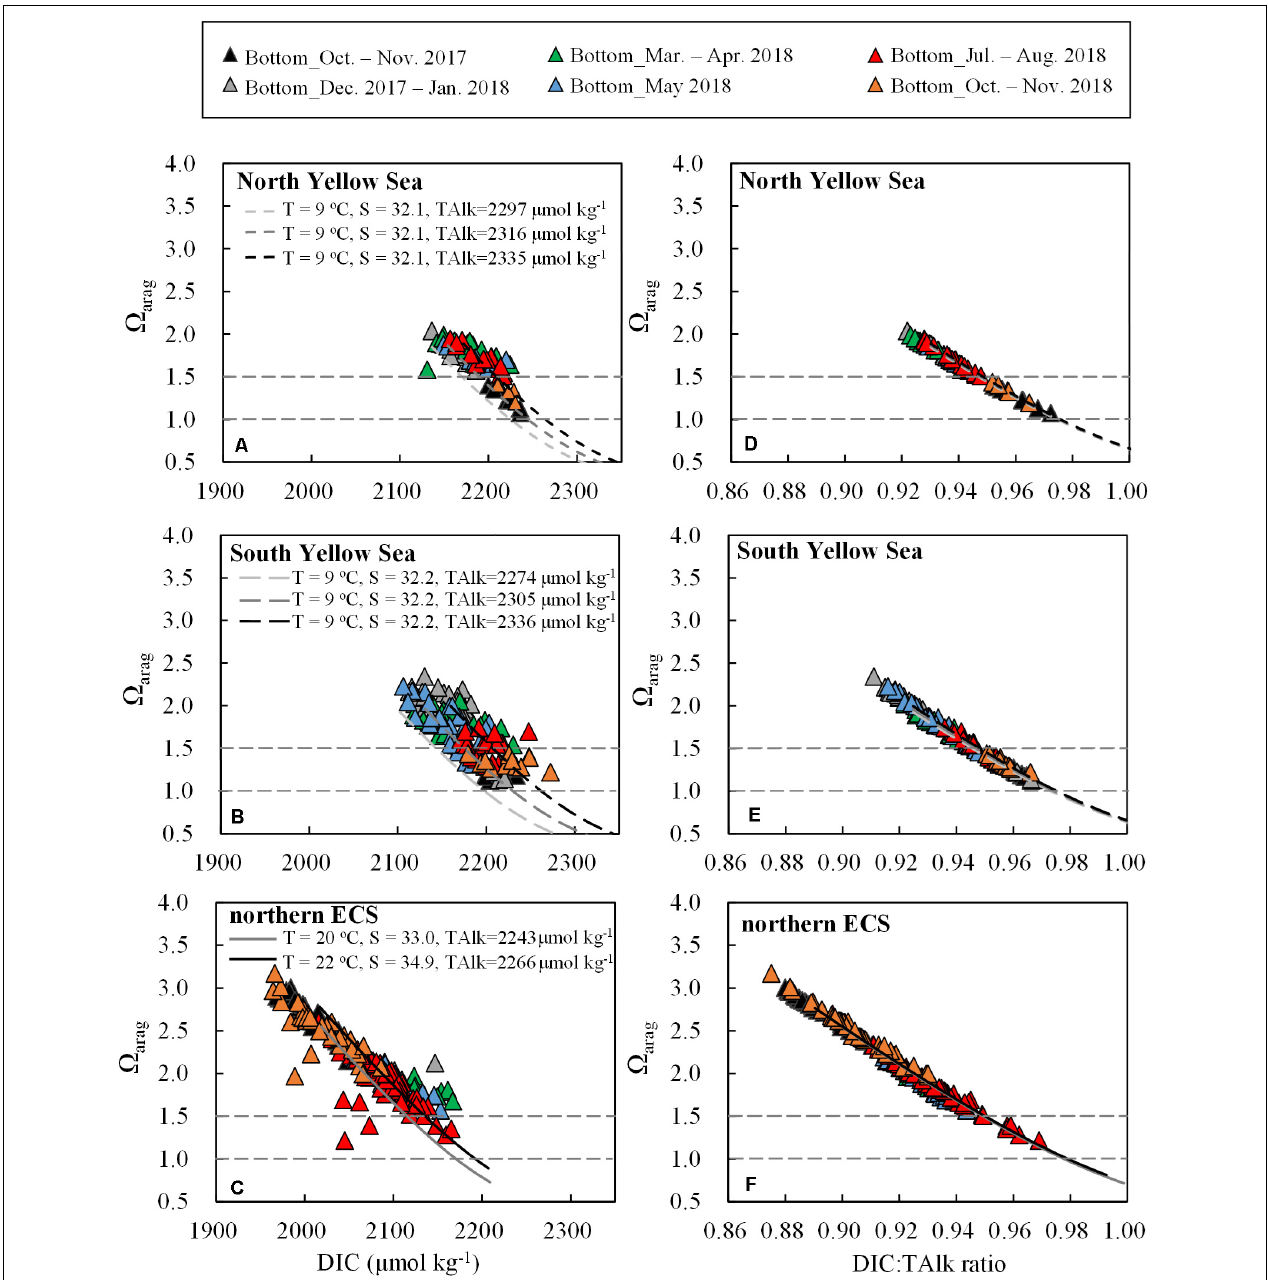
FIGURE 8 | Plots of bottom-water (cid:127) arag versus (A–C) DIC and (D–F) DIC:TAlk ratio. Black and gray curves represent ideal relationships between (cid:127) arag versus DIC and DIC:TAlk ratio using CO2SYS.XLS. During calculation, starting condition for the North Yellow Sea was DIC:TAlk ratio = 0.930; starting condition for the South Yellow Sea was DIC:TAlk ratio = 0.925; starting condition for the northern ECS was DIC:TAlk ratio = 0.900, while for the ECS offshore waters was DIC:TAlk ratio = 0.890. The impact of respiration on TAlk ( (cid:49) TAlk: (cid:49) DIC = –17/106) was included.